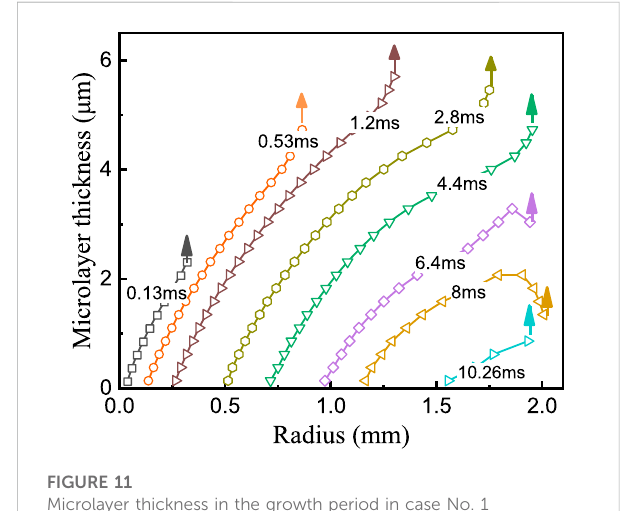
FIGURE 11 Microlayer thickness in the growth period in case No. 1